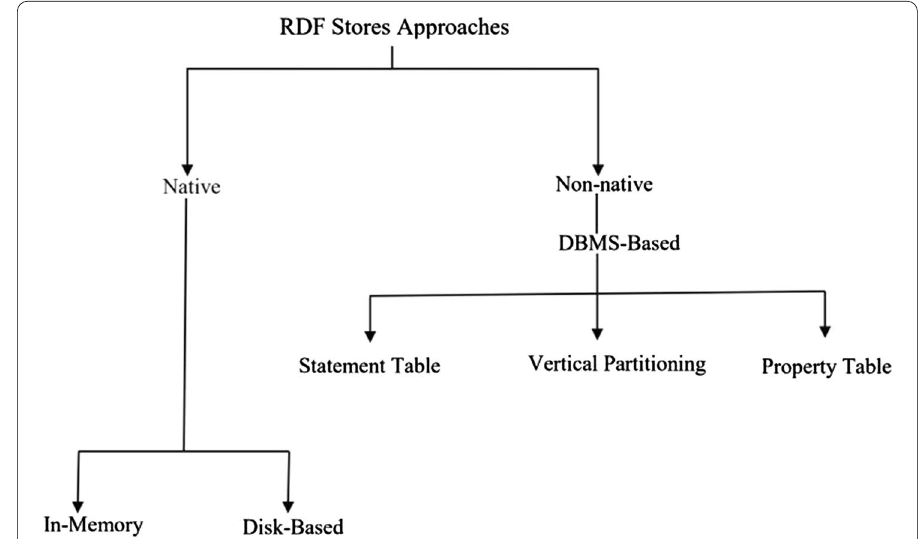
Fig. 1 A taxonomy of RDF storage approaches adopted from